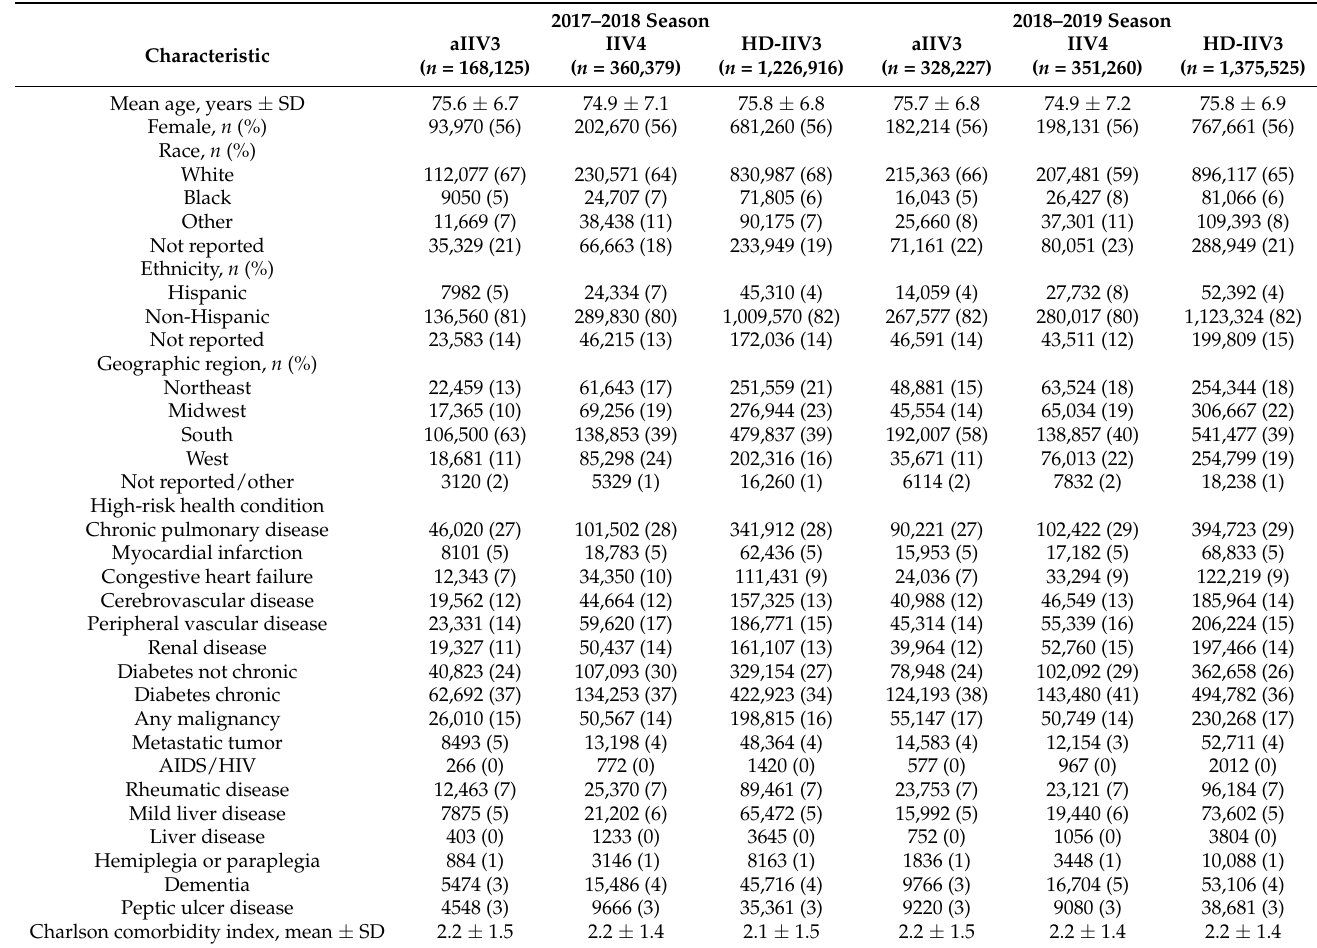
Table 1. Subject demographics at